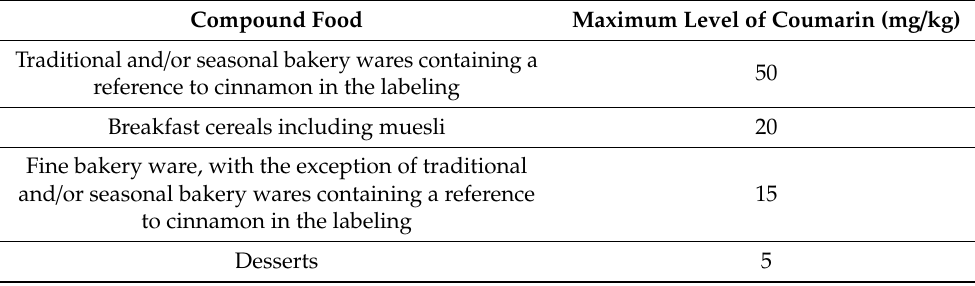
Table 1. Compound food in which the presence of the coumarin is restricted